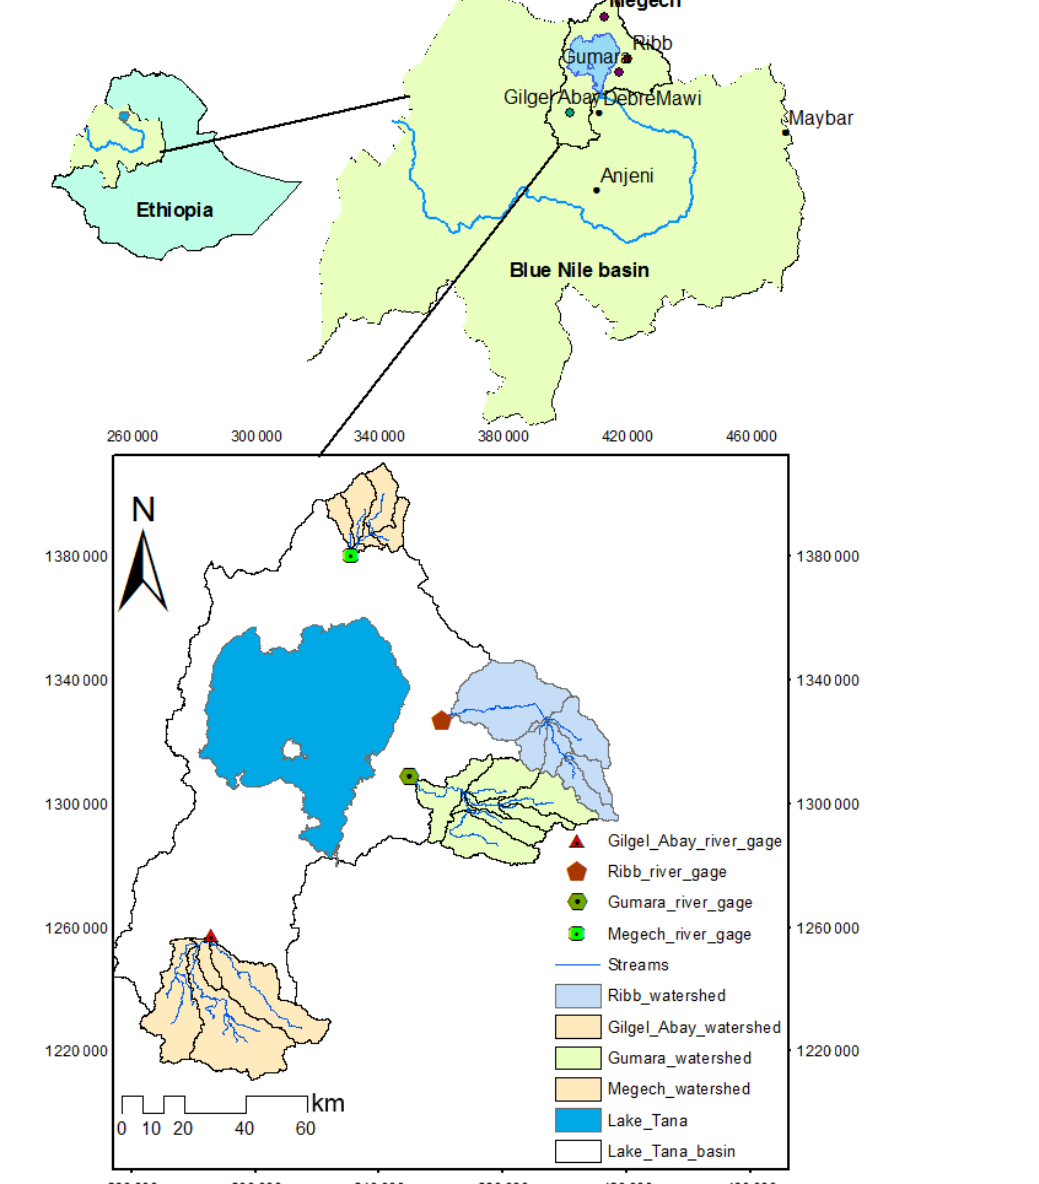
Figure 2. Location maps of the Lake Tana watersheds (Gilgel Abay, Gumara, Ribb and Megech) and 100ha watershed 100ha watersheds (Debre Mawi, Anjeni and Maybar) in or close to the Blue Nile